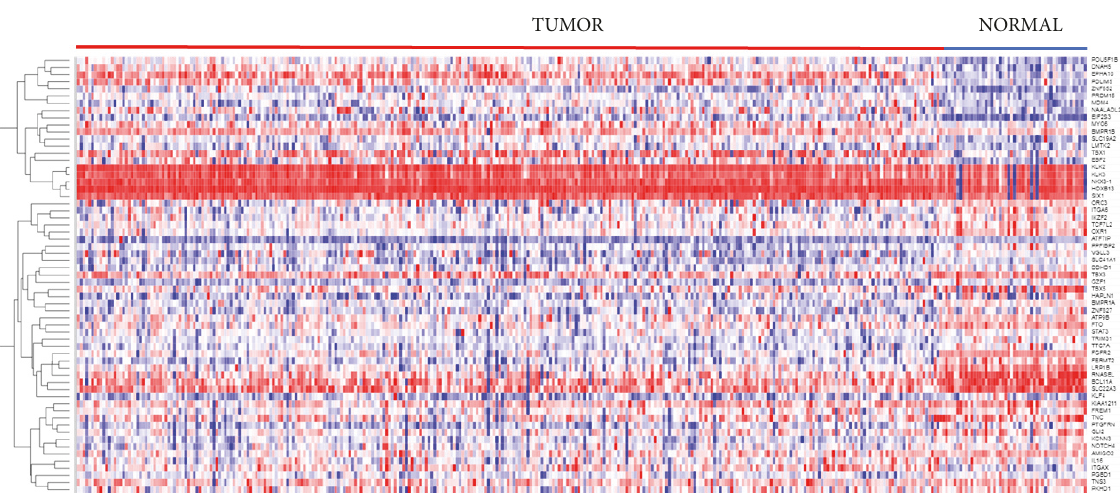
Figure 3: Patterns of expression profiles for the 61 genes containing both germline and somatic mutations distinguishing patients with aggressive tumors and controls generated using hierarchical